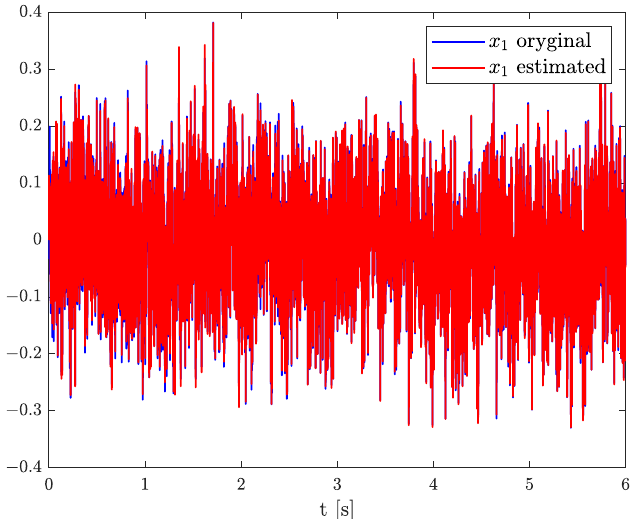
Figure 2. Original and estimated state variable from Example